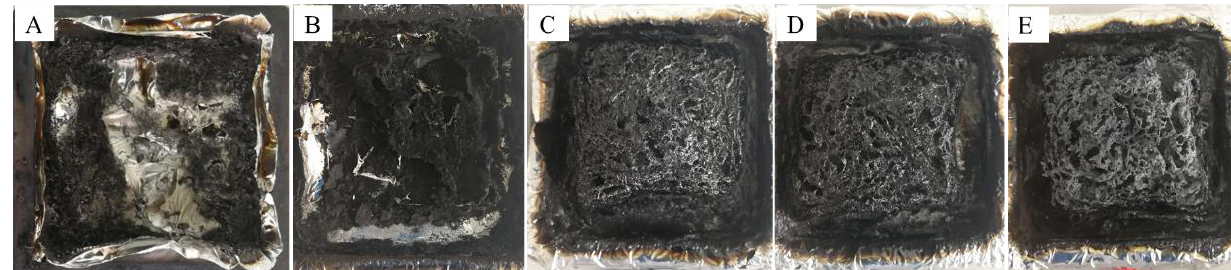
Figure 10. Char residue of epoxy resin composite. ( A ) Pure EP; ( B ) EP/MMT; ( C ) EP/DOPO; ( D ) EP/DOPO+MMT; ( E ) EP/DOPO-MMT.